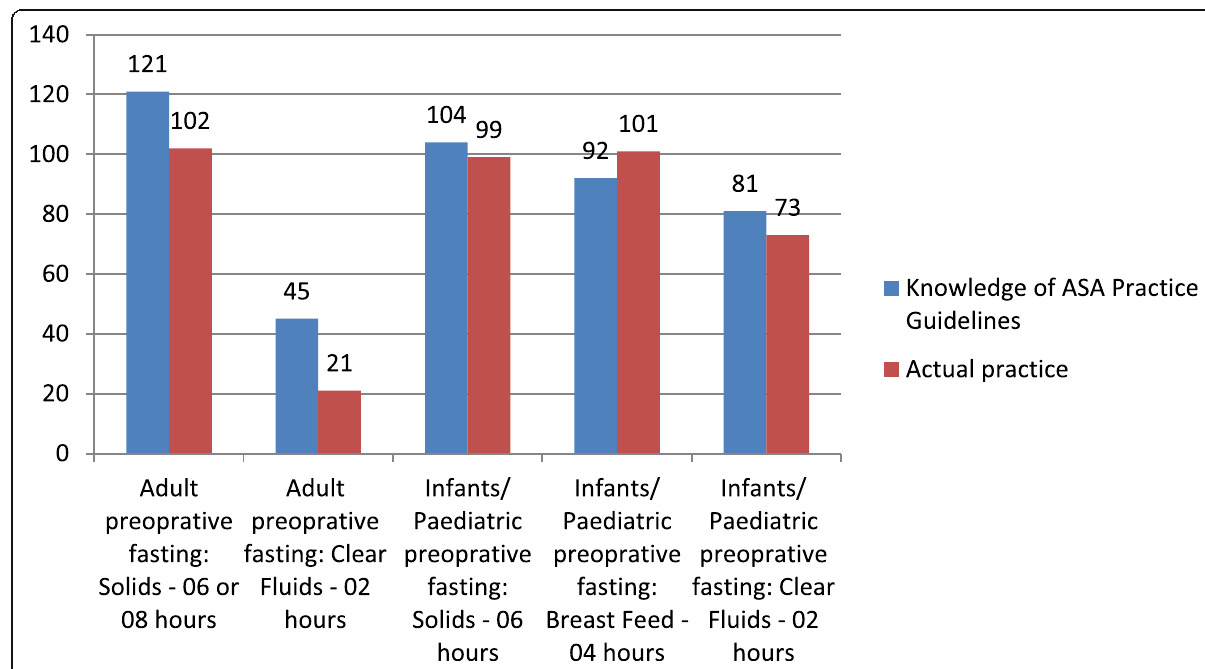
Fig. 1 Knowledge and actual practice of preoperative fasting by postgraduate trainee respondents